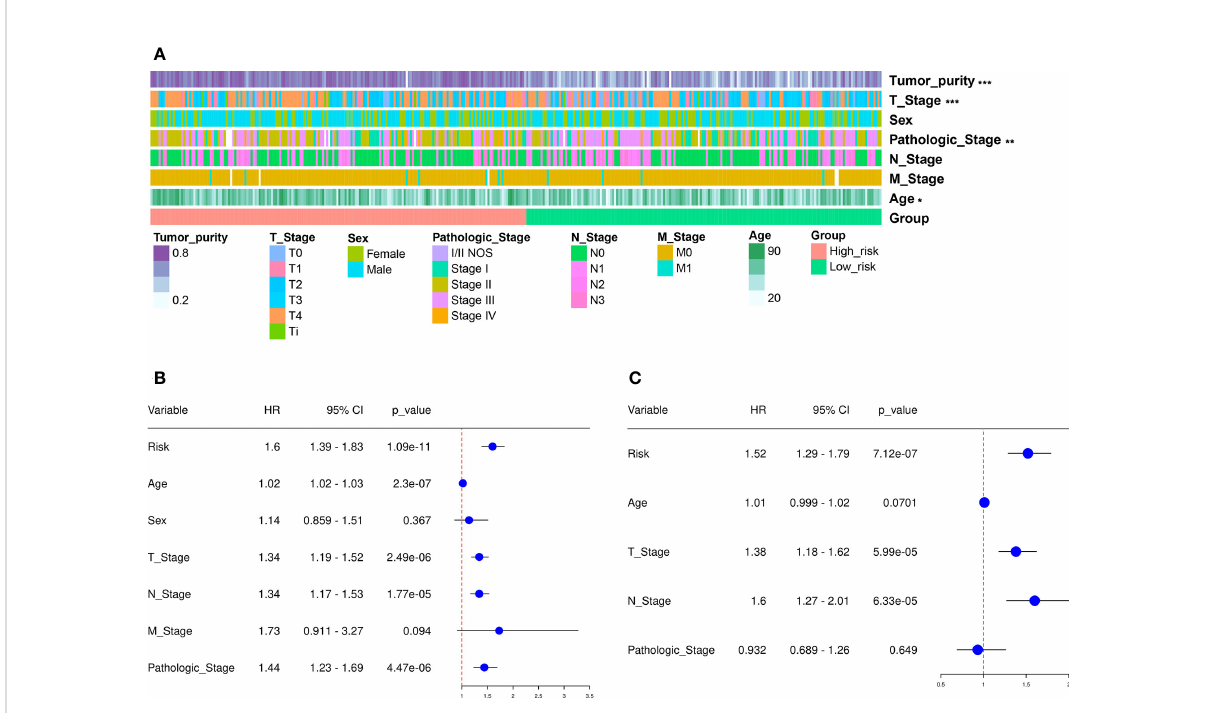
FIGURE 4 Clinical assessment using the risk assessment model. (A) A heatmap reveals the distribution of tumor purity, T stage, sex, pathologic stage, N and M stages, and age, along with RS. (B) The univariate Cox regression analysis was used to examine the associations among the RS, clinical features, and OS of SKCM patients. (C) Multivariate Cox regression analysis was employed to reveal the associations present among the RS, clinical features, and OS of SKCM patients. *p < 0.05, **p < 0.01, ***p <